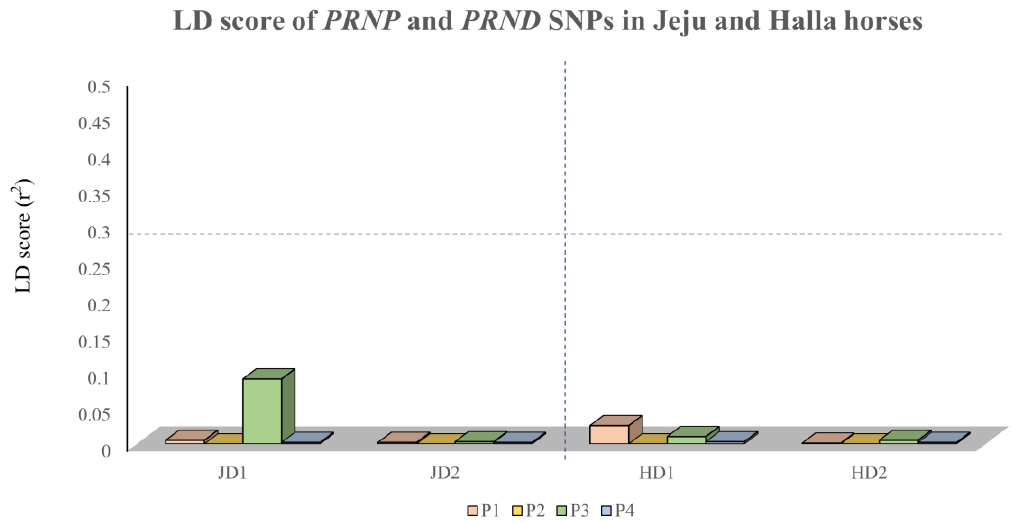
Figure 3. Measurement of linkage disequilibrium (LD) values between PRNP and PRND SNPs in Jeju and Halla horses. JD1 and HD1 indicate horse PRND c.331G > A (codon 111), and JD2 and HD2 indicate horse PRND c.411G > C (codon 137). P1 ~ P4 indicate horse PRNP SNPs as follows: P1, c.-3A > G; P2, c.301T > A (codon 101); P3, c.525C > A (codon 175); and P4, c.570G > A (codon 190). Table 6. Linkage disequilibrium (LD) between single nucleotide polymorphisms (SNPs) in the PRNP and PRND genes with r 2 values in Jeju and Halla horses. PRND